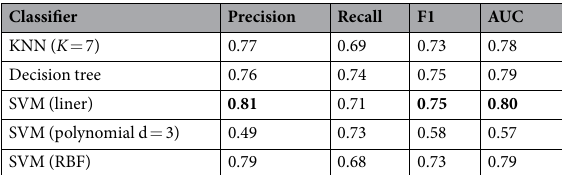
Table 2. The Classification Performance of Different Classifiers. SVM (linear), SVM (polynomial d = 3) and SVM (RBF) means the kernel function of SVM is linear, polynomial, and radial basis function, respectively.